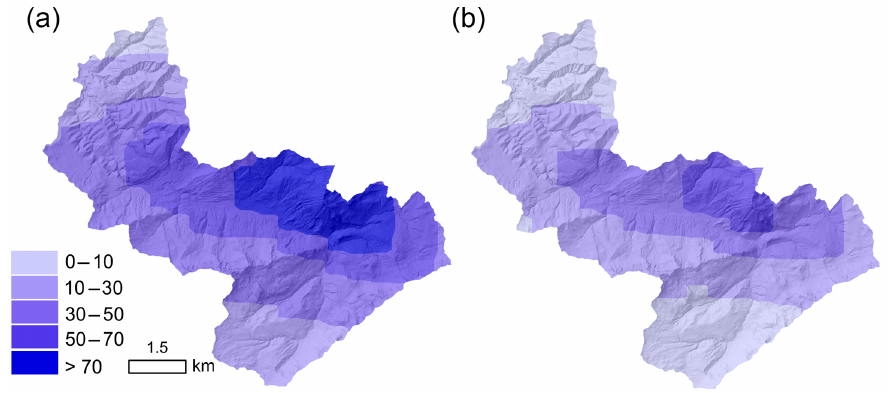
Figure 2. Map of the spatial distribution of precipitation (mm) on 24 July 2014 in the upper Emme catchment: (a) total event precipitation (mm) from 04:00 to 17:00LT; (b) maximum hourly precipitation recorded at